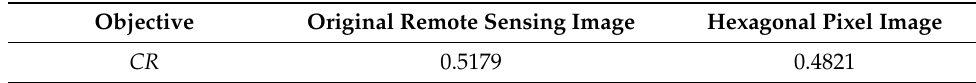
Table 3. Weight of the objective options.